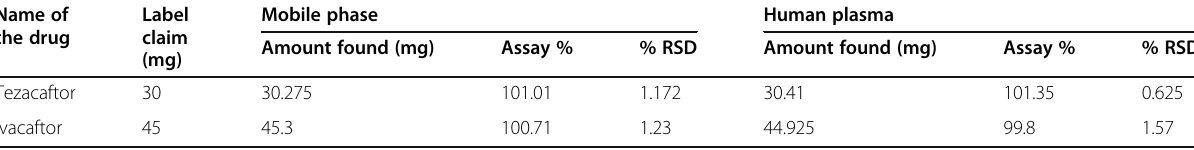
Table 12 Assay studies of Tezacaftor and Ivacaftor in mobile phase and human plasma Name of the drug